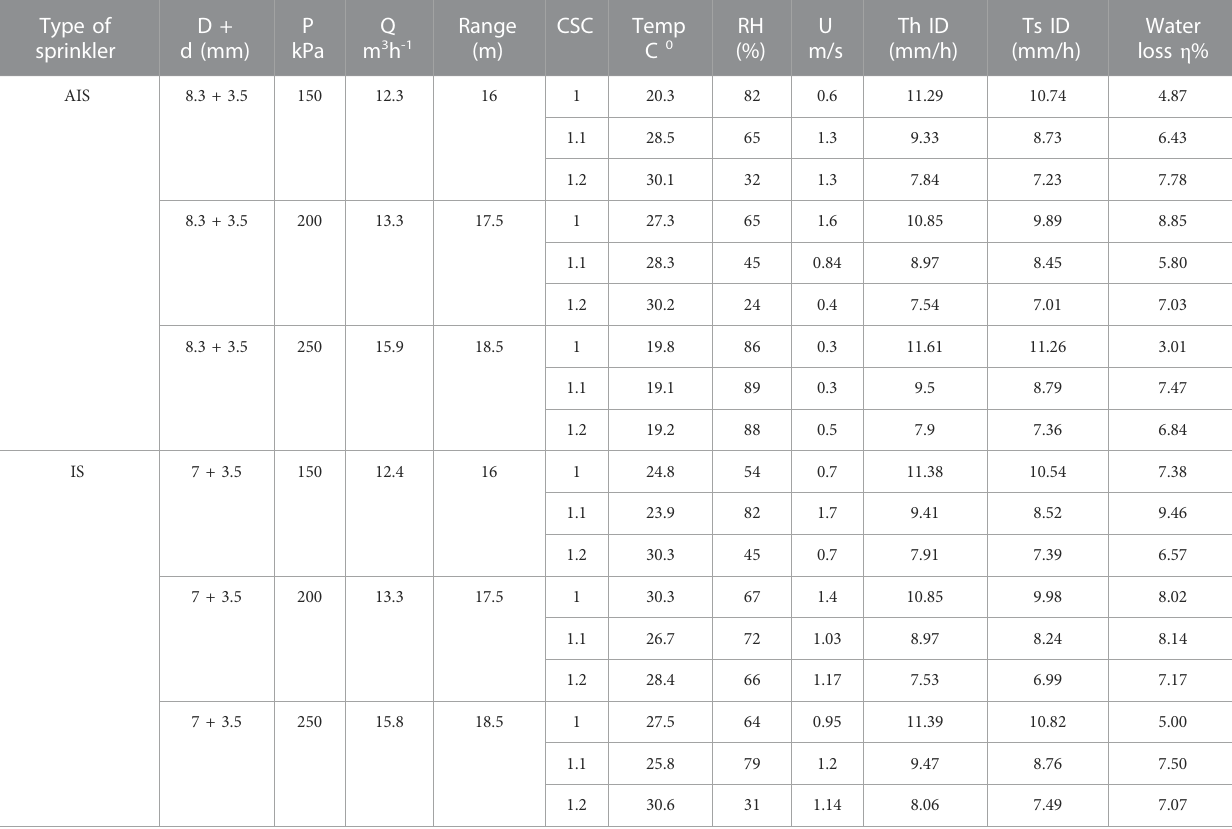
TABLE 1 Outdoor operational and metrological parameters of the solid set experiment with different pressures and lateral spacing. Type of